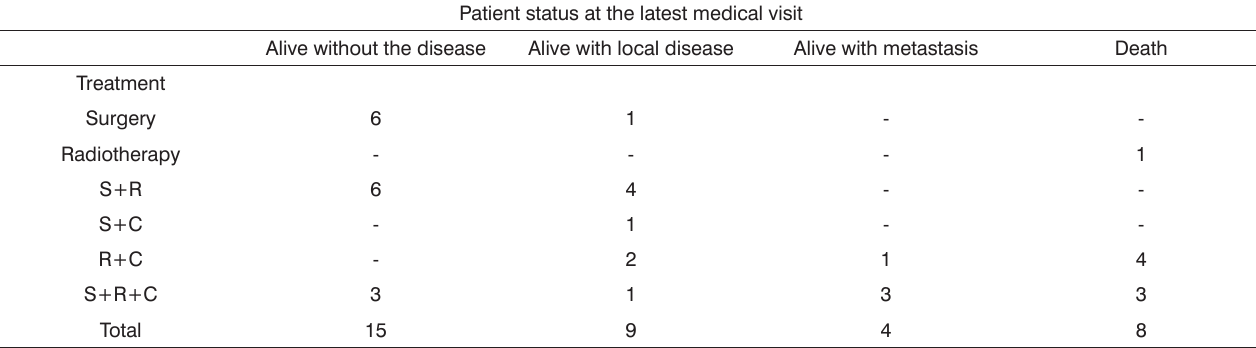
Table 4. Sample distribution according to treatment and patient status at the latest